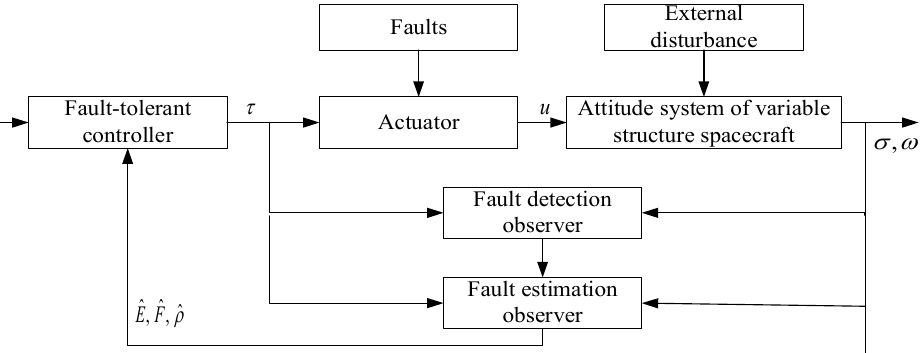
Figure 1. The structure of the active FTC scheme.